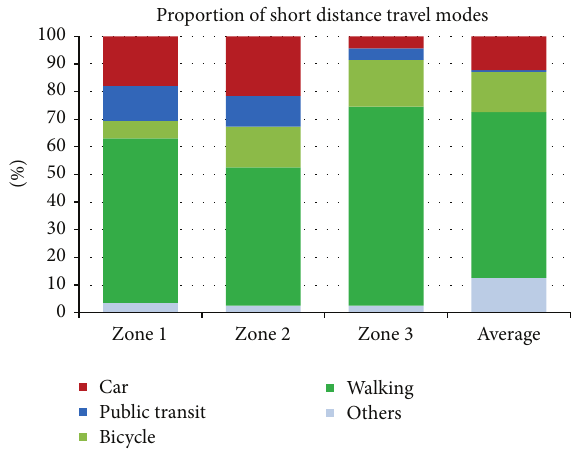
Figure 2: Proportion of short distance travel modes in three TAZs.